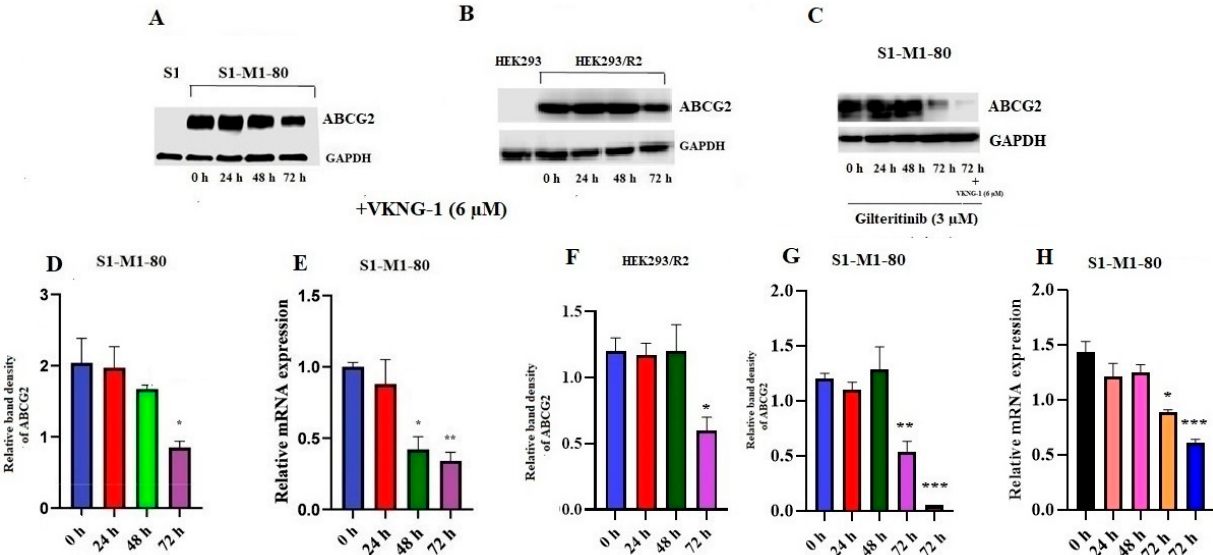
Figure 3. Effect of VKNG-1 and gilteritinib on the expression of ABCG2: The relative intensity of ABCG2 in S1-M1-80 cells ( A ), HEK293/R2 cells ( B ) was tested after the cells were incubated with 6 µM of VKNG-1 for 24, 48 and 72 h and in S1-M1-80 cells ( C ) after they were incubated with 3 µM of gilteritinib for 24, 48 and 72 h and with a combination of 6 µM of VKNG-1. Relative quantification of the effect of VKNG-1 on ABCG2 in S1-M1-80 cells ( D ) HEK293/R2 ( F ) and the effect of combination of VKNG-1 and gilteritinib on the expression of ABCG2 in S1-M1-80 cells ( G ). The expression level of the target protein (ABCG2) was normalized to GAPDH. Equal amounts of total cell lysates were employed for each sample and Western blot analysis was conducted. The effect of VKNG-1 ( E ) and the combination of VKNG-1 and gilteritinib ( H ) on the expression of ABCG2 in S1-M1-80 cells at mRNA level, normalized to the house keeping gene, 18S . * p < 0.05, ** p ≤ 0.01 and *** p ≤ 0.001 compared to the control group.